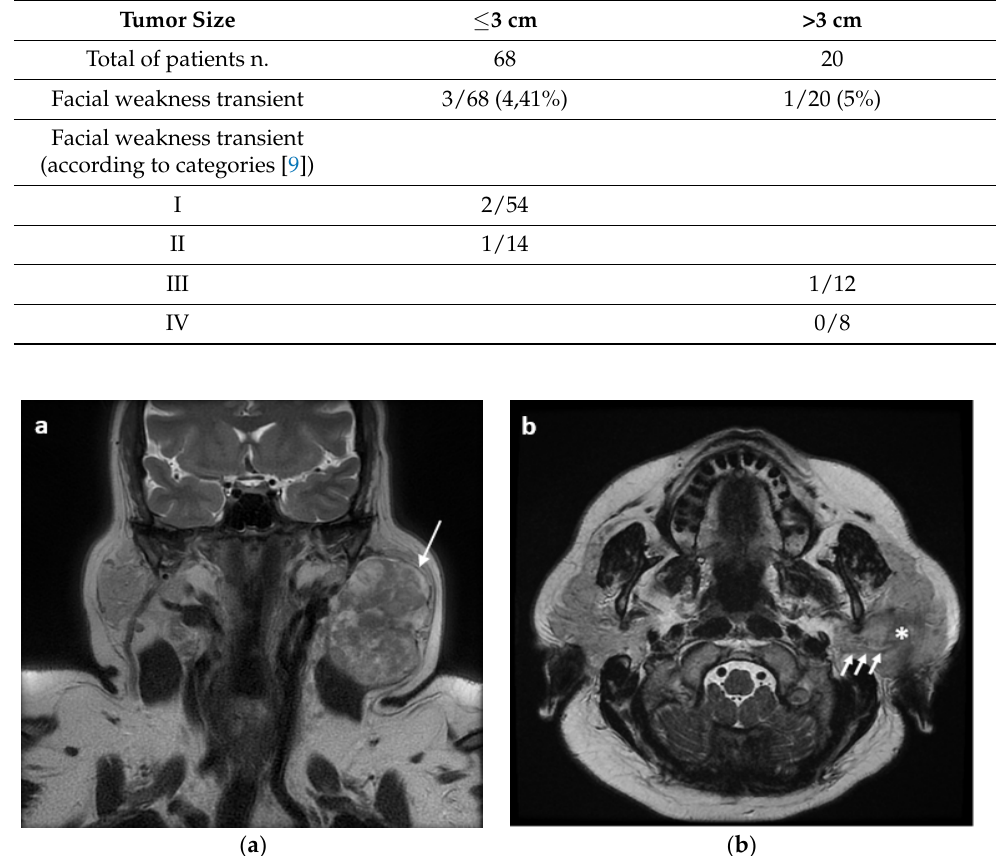
Figure 1. Pleomorphic adenoma of the left parotid gland in a 40-year-old woman. ( a ) Coronal T2-weighted MR image shows a heterogeneously hyperintense mass with the entire capsule (arrow) in the left parotid gland. ( b ) Axial T2-weighted MR image showing the neoplasm (asterisk) with adhesion to facial nerve (arrows).